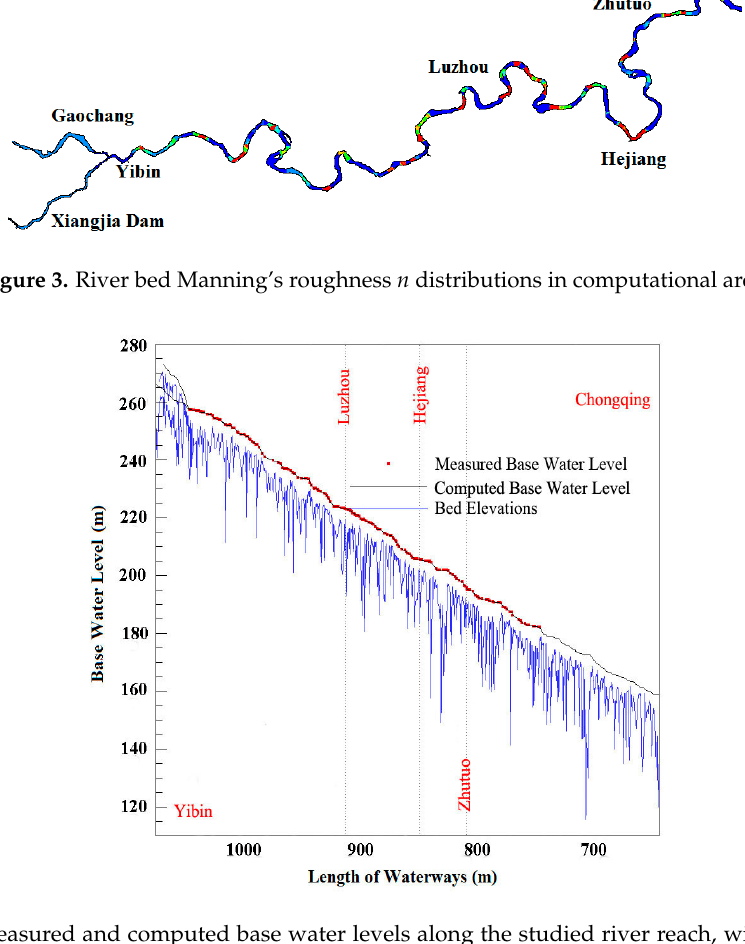
Figure 4. Measured and computed base water levels along the studied river reach, with blue lines indicating the deepest trench topography.